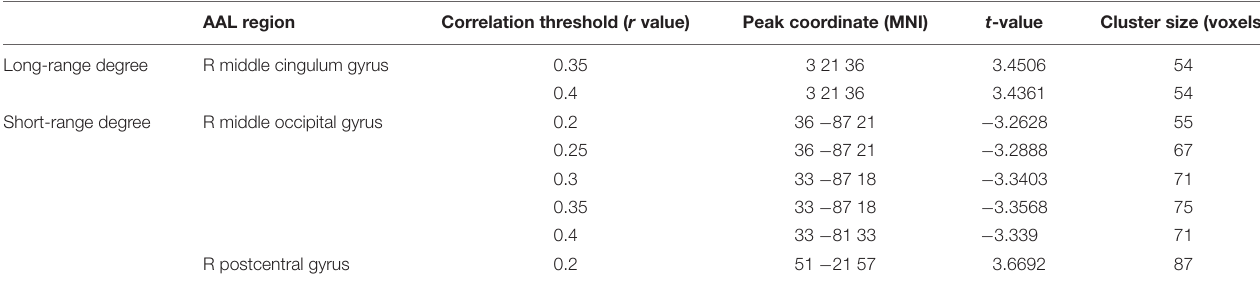
TABLE 3 | Longitudinal degree analysis on the dynamic alteration pattern between PMCI and SMCI groups in 1-year duration. AAL region R middle cingulum